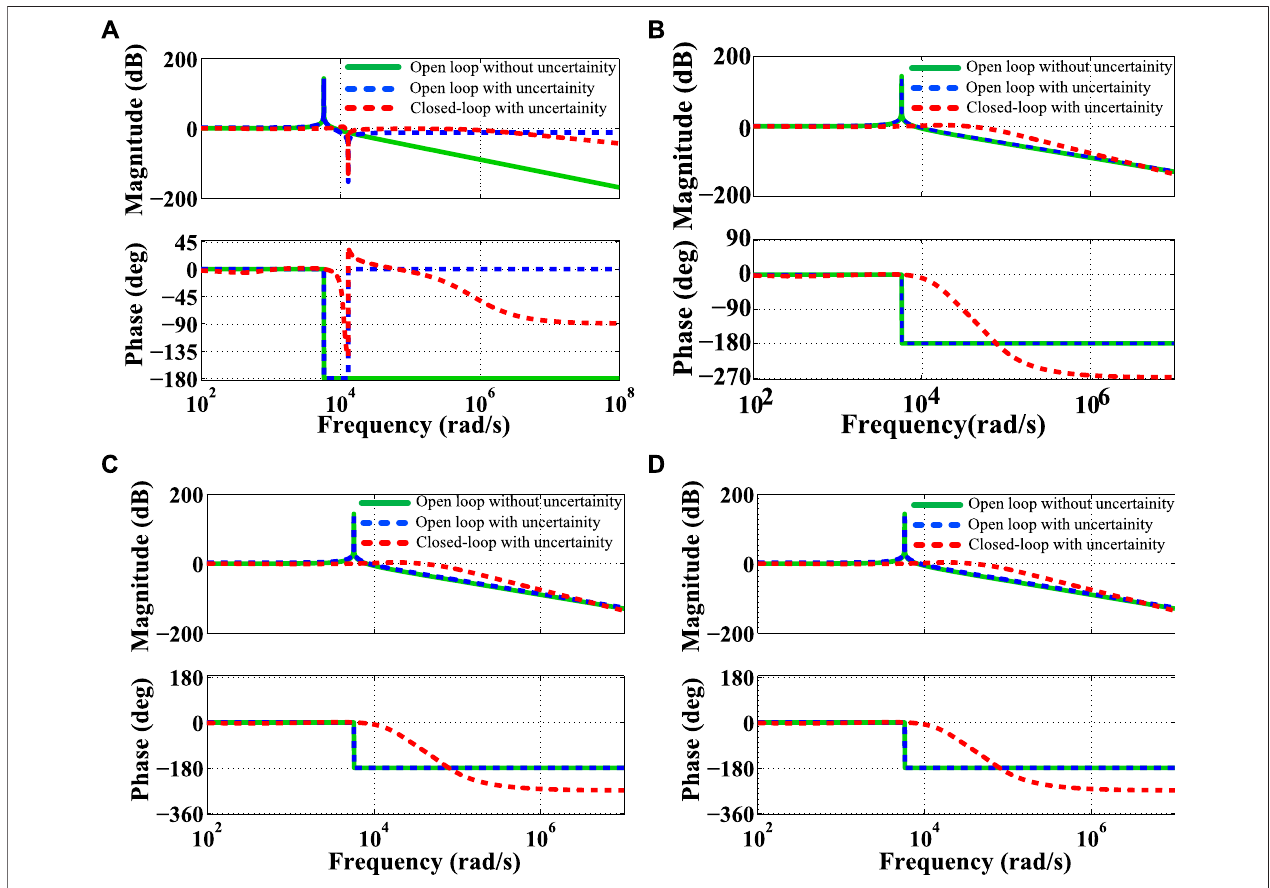
FIGURE 6 | Comparison of Bode diagram using open and closed-loop: (A) for Figure 5A; (B) for Figures 5B,C; (C) for Figure 5D; (D) for Figures 5E,F.